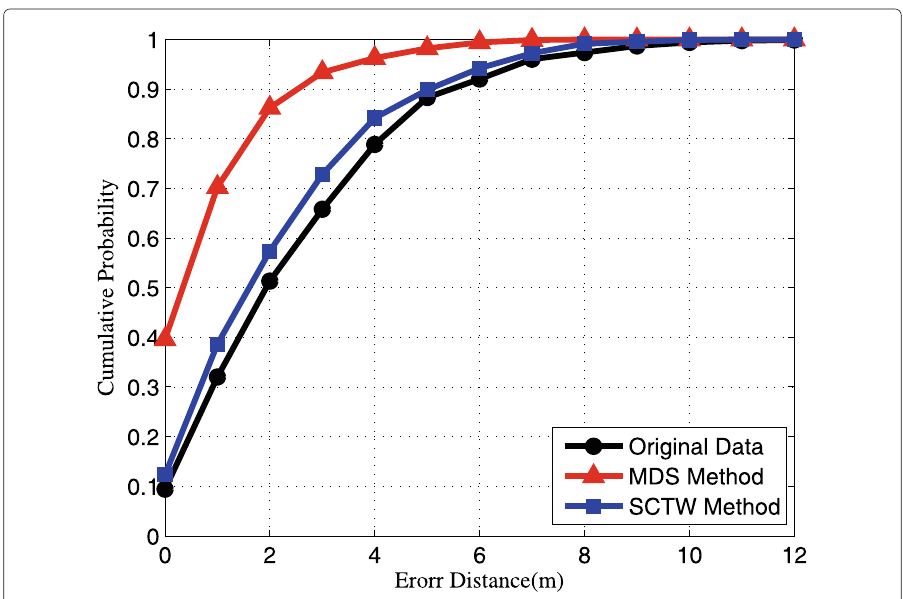
Fig. 17 Cumulative distribution function of Positioning error